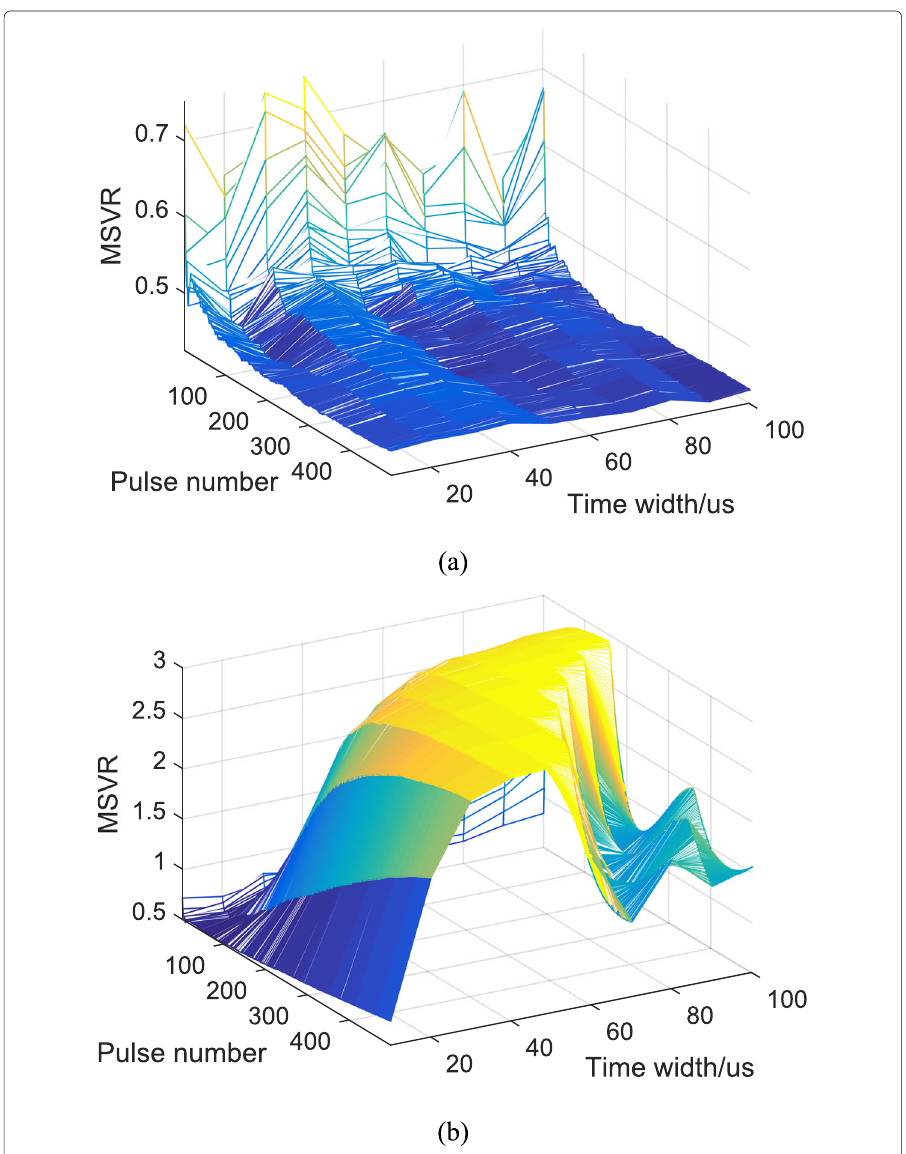
Fig. 4 The MSVR of target echo and VGPO jamming under different time width and pulse numbers